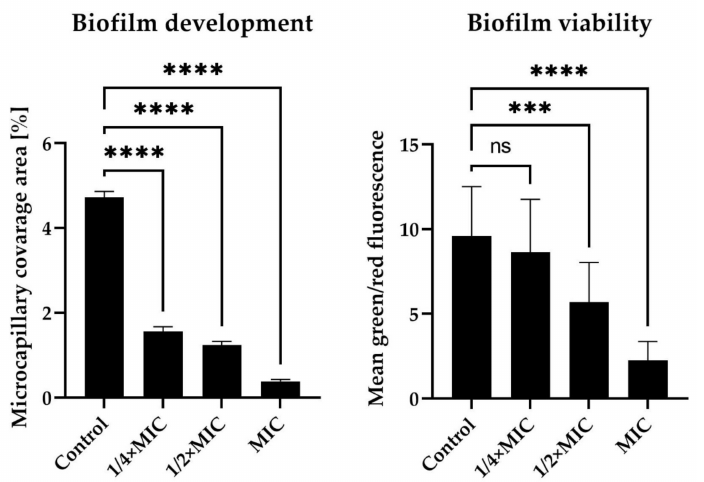
Figure 5. Data quantifying anti-biofilm activity of dioscin against H. pylori J99 after 24-h incubation under flow conditions. The flow conditions were generated using the Bioflux 1000 system. The × MIC, and 1 × MIC had values of 64 µ g/mL, 32 µ g/mL, and 16 µ g/mL, respectively. MIC, 1 2 4 Control samples were bacteria not exposed to any concentration of dioscin. Viability was defined as the ratio of green to red fluorescence of bacterial cells stained with the LIVE/DEAD kit, while the development of biofilm was verified by determining the degree of capillary coverage (both parameters were determined using the Bioflux Montage software). The study was performed with triplicate biological replications ( n = 3). The p -value represented by ns, ***, and **** is equal to > 0.05, < 0.001, and < 0.0001,